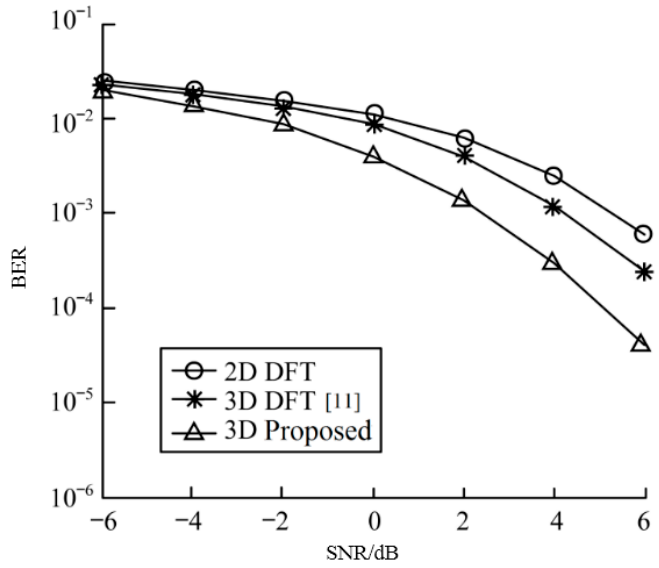
Figure 8. The relationship between the BER and SNR for the proposed precoding scheme and other schemes.